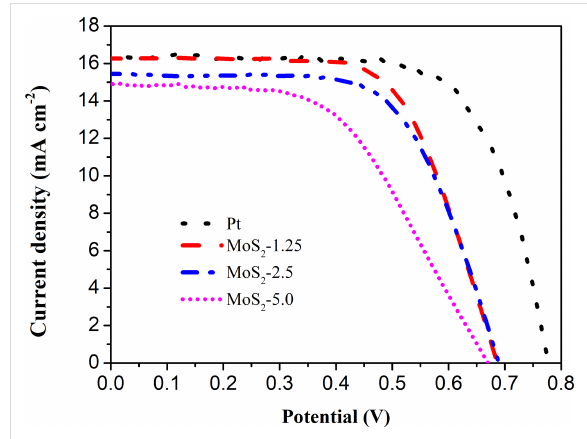
Figure 7: Photovoltaic performance of DSSCs fabricated with different MoS 2 /FTO and Pt/FTO CEs. other reports (Table 3). The PCE for DSSCs using MoS 2 with different thicknesses decreased in the order: MoS 2 -1.25 (very thin film) > MoS 2 -2.5 (50 nm) > MoS 2 -5.0 (500 nm). This is in good agreement with the trend of R s and R ct1 values (see Table 2 and Table 3). The effect of film thickness on the elec- trical conductivity of the MoS 2 films was also investigated by I – V measurements (see Supporting Information File 1, Figure S2 and Table S1). The electrical conductivity of the as-pre-